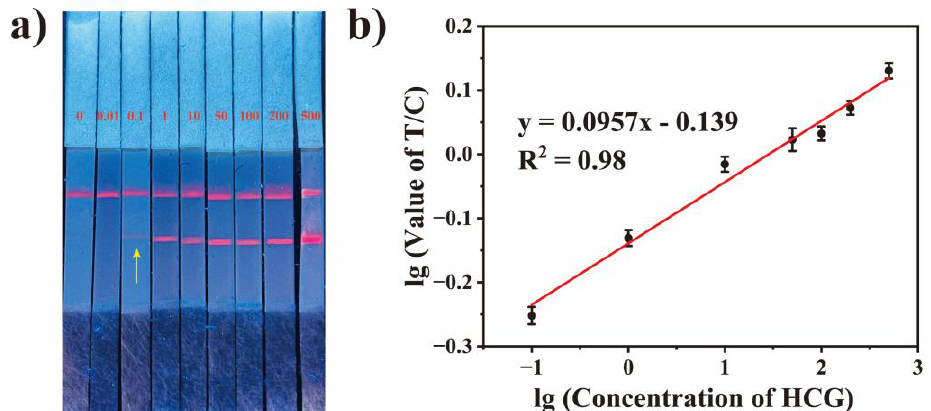
Figure 5. ( a ) Image of the MF@CdSe/ZnS@PEI-ICTS when detecting HCG standard solution (0, 0.01, 0.1, 1, 10, 50, 100, 200, and 500 mIU/mL). ( b ) Linear response of MF@CdSe/ZnS@PEI-ICTS for detection of HCG.